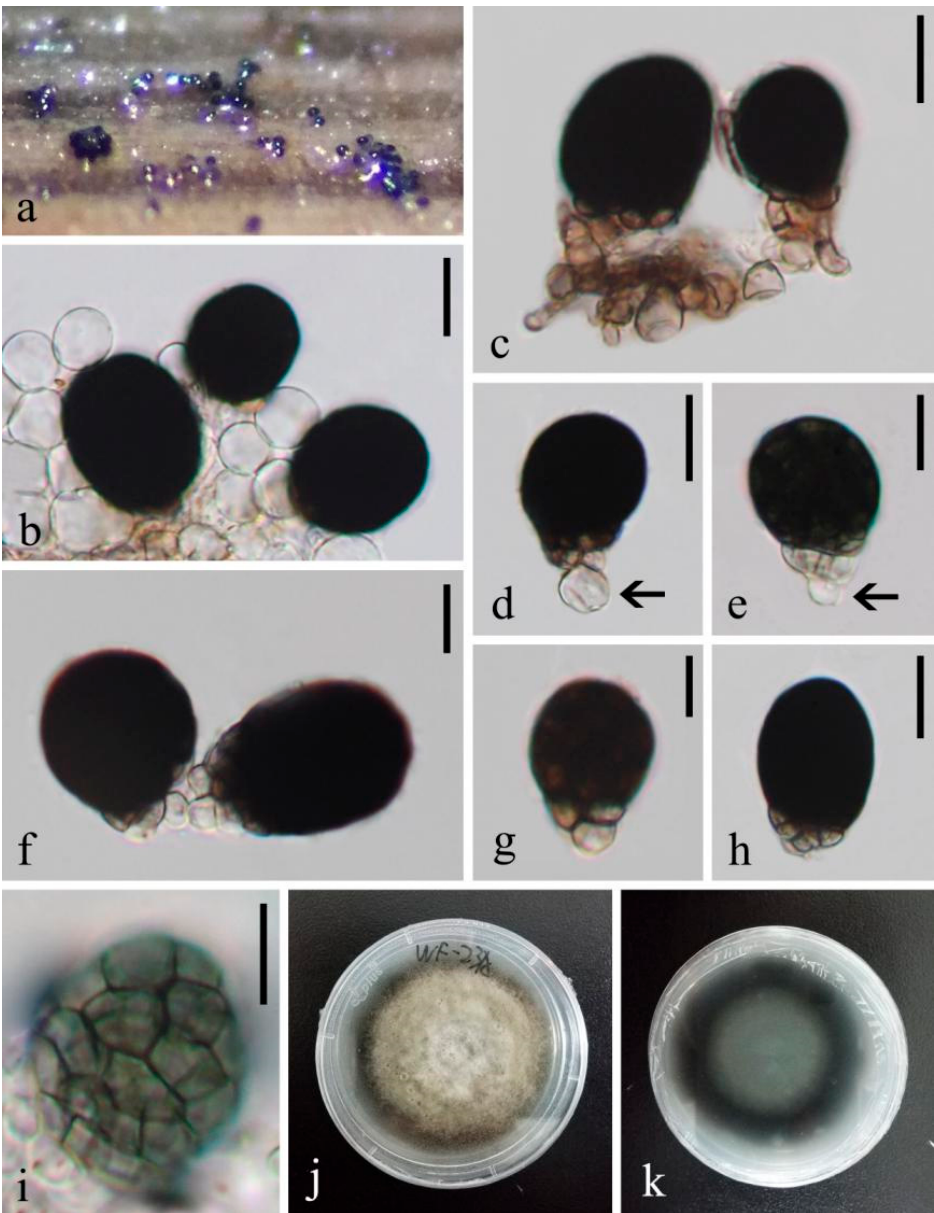
Figure 5. Saprodesmium dematiosporum (HKAS 101710, holotype). ( a ) sporodochia with a mass of conidia and scattered conidia on natural substrate; ( b ) conidia and conidiophores; ( c ) conidia attach on pseudoparenchyma of sporodochia; ( d , e ) conidia with conidiogenous cells (arrows); ( i ) conidial surface showing muriform patttern; ( j , k ) colony on PDA (left-front, right-reverse). Scale bars, ( b – e , h ) 15 μ m; ( f , g , i ) 10 μ m. Index Fungorum number : IF558197; Facesoffungi number: FoF